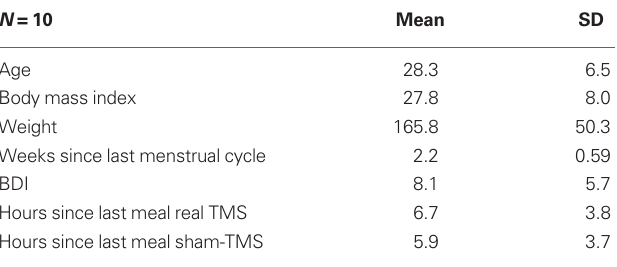
Table 1 | Means and standard deviations for participant characteristics and scores on the